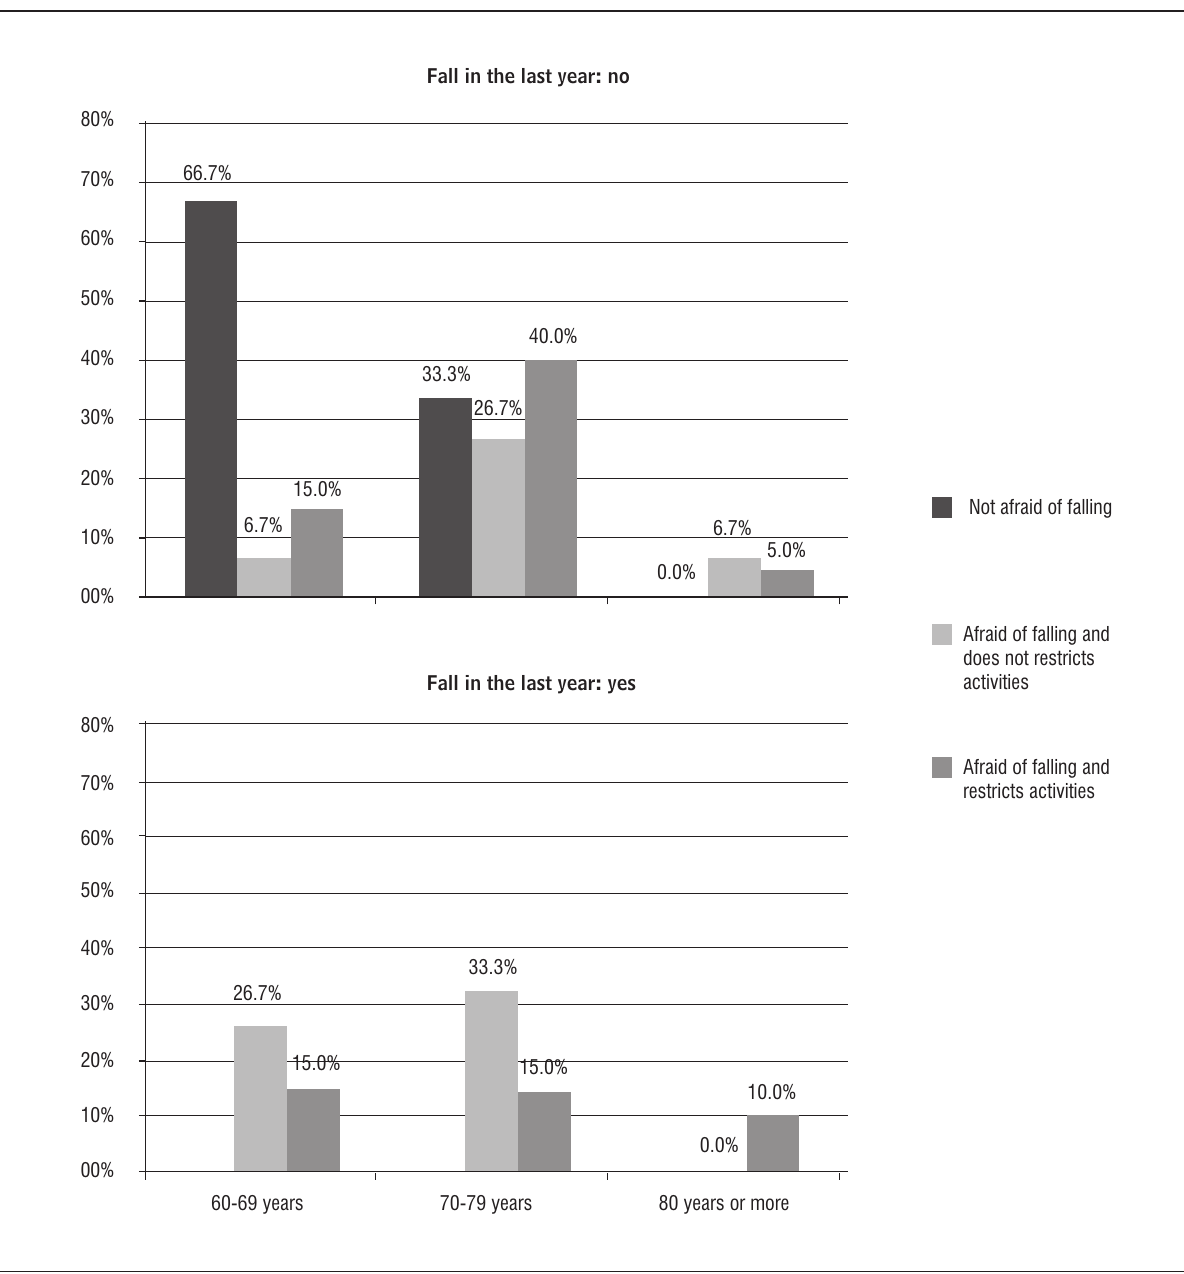
Figure 2 - SAFFE: classification by age group in relation to history of falls Source: Research